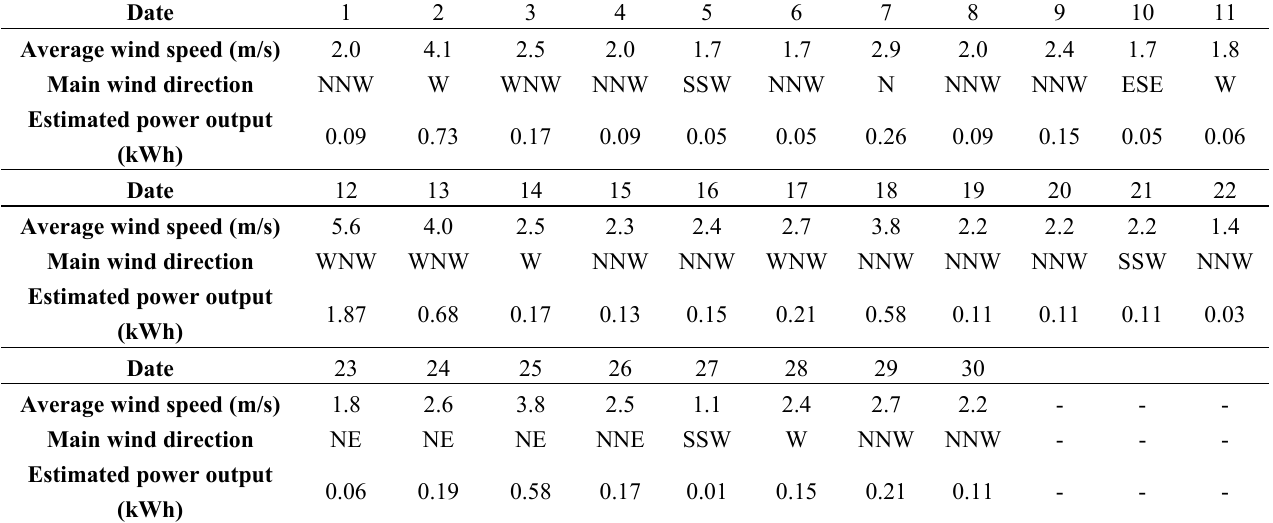
Table A11. Estimated power output per day in November.